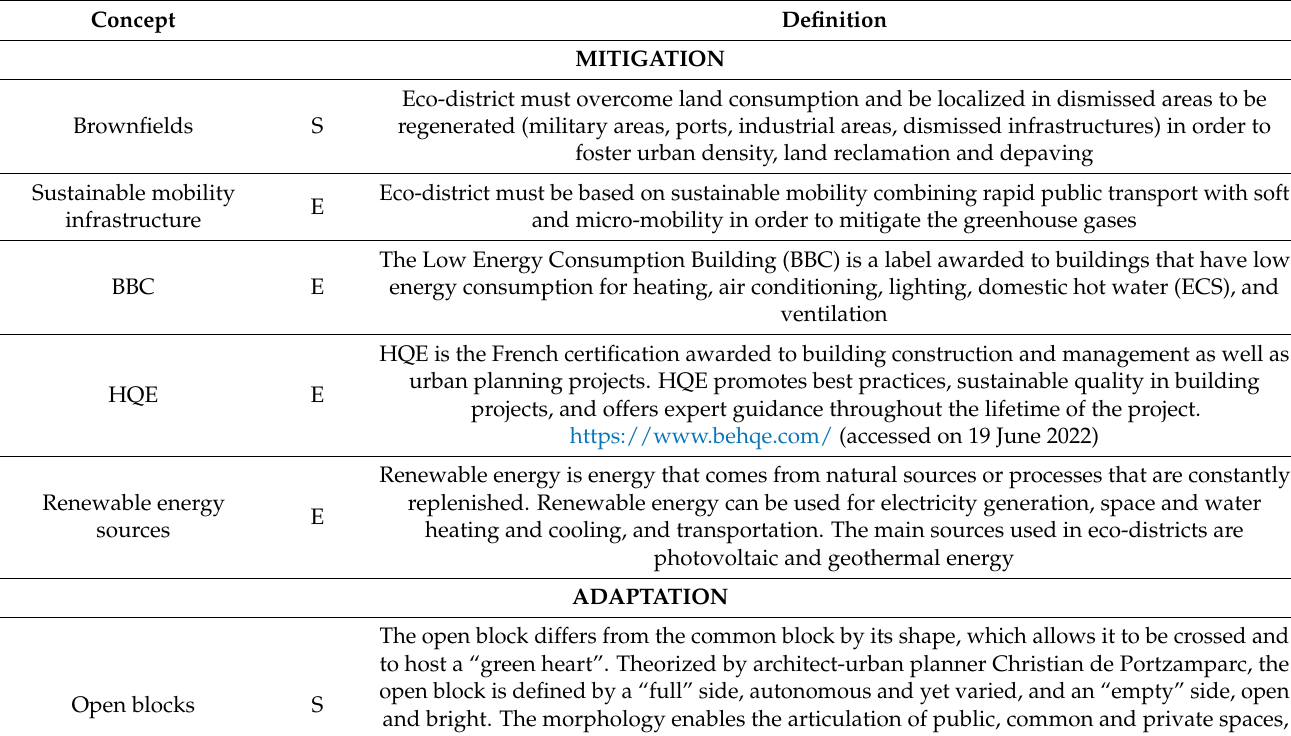
Table 17. The eco-district framework. Source: Authors’ elaboration (2022) from the analysis of the 4 case studies, data based on http://www.ecoquartiers.logement.gouv.fr and on survey/onsite visit (accessed on 19 June